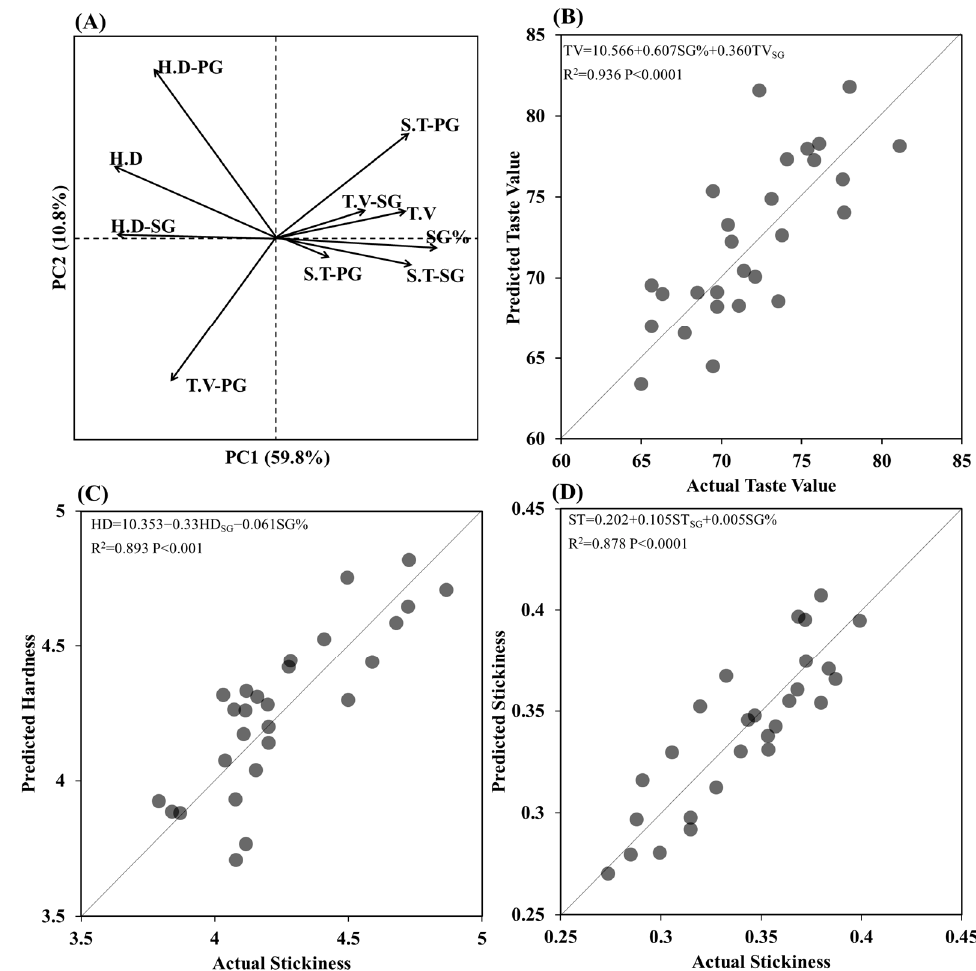
Figure 8. PCA analysis among taste value characteristics of grains located on different position ( A ) and of the population and the Stepwise regression analysis of taste value ( B ), hardness ( C ) and stickiness ( D ). Note : H.D represents hardness of rice; H.D-PG represents hardness of grains located in primary branches (PG); H.D-SG represents hardness of grains located in secondary branches (SG); S.T represents hardness of rice; S.T-PG represents hardness of PG; S.T-SG represents hardness of SG; T.V represents hardness of rice; T.V-PG represents hardness of PG; T.V-SG represents hardness of SG; SG% represents ratio of SG per unit area.